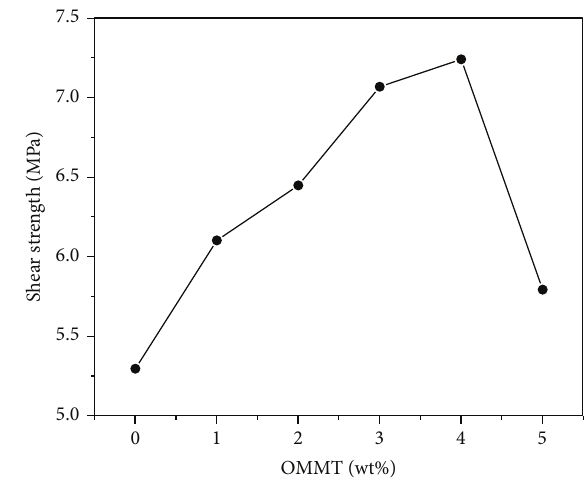
Figure 6: The shear strength curve of OMMT/PU.